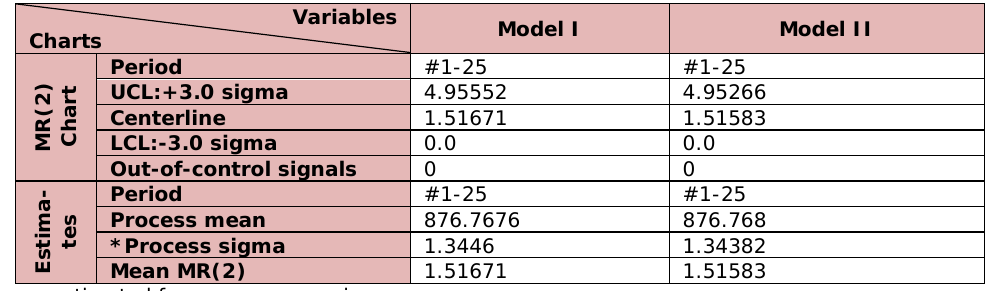
Table 6. “Trend charts parameters of